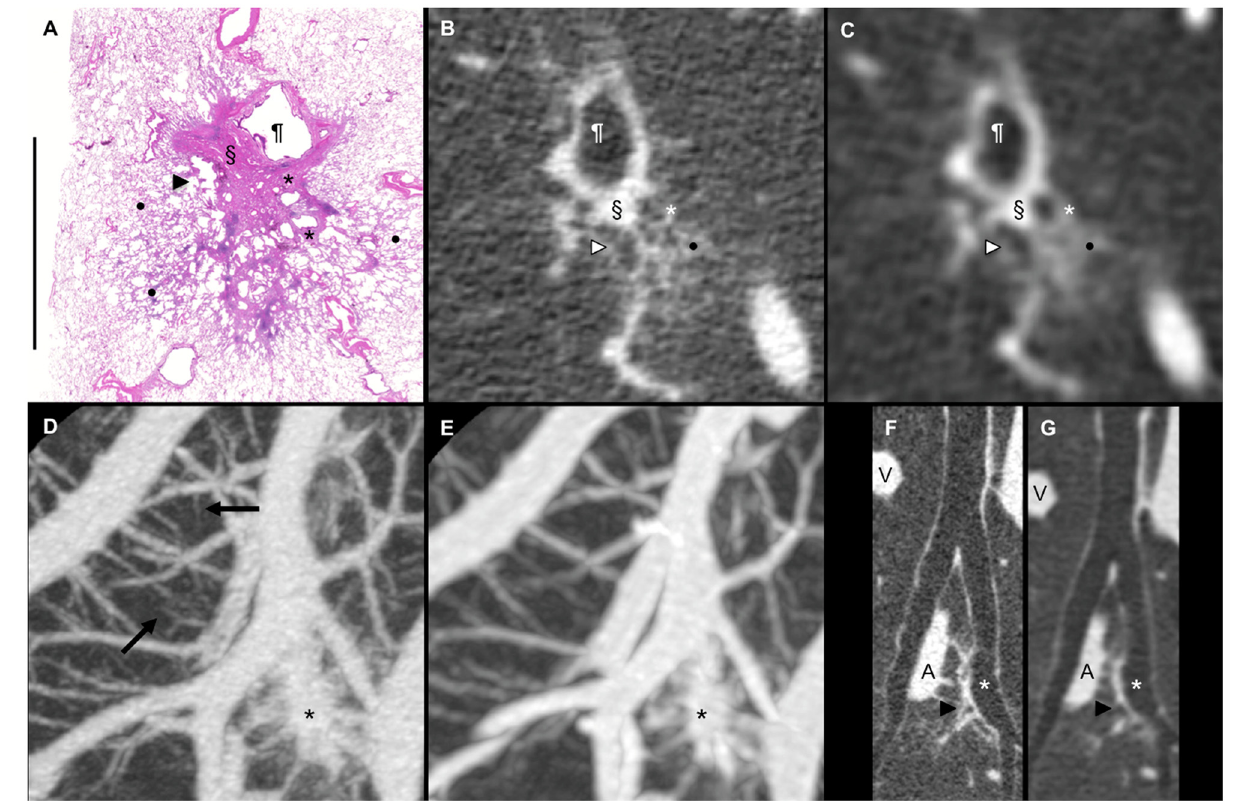
Fig 5. CT-pathologic correlation of an adenocarcinoma in situ. The patient was a 58-year-old female with adenocarcinoma in situ (size, 18 x 16 mm; pT1aN0M0, stage IA). The part-solid nodule was located in segment 6 of the right lower lobe. (A) Loupe view of the pathology specimen (Scale: 1 cm) (H & E, original magnification x1.25). (B) Multiplanar reconstruction (MPR) image from the ultra-high-resolution CT (U-HRCT) data corresponding to the pathology specimen. (C) MPR image from the conventional high-resolution CT (C-HRCT) data corresponding to the pathology specimen. U-HRCT image (Fig B) clearly depicting the solid component (§) immediately adjacent to the bronchial wall (¶) and low-attenuation areas, indicated by a white arrowhead and a white star, in the GGO component of the part-solid nodule. Collapse of the alveolar spaces (§) in Fig 5A corresponds to the solid component (§) of the part-solid nodule on the U-HRCT and C-HRCT images (Fig 5B and 5C), and the enlarged bronchiole (black arrowhead) and enlarged alveolar air spaces (black stars) in Fig 5A correspond to the low-attenuation areas (white arrowhead and white star) in the GGO component of the part-solid nodule on the U-HRCT and C-HRCT images (Fig 5B and 5C). The lepidic component indicated by the black dots in Fig 5A corresponds to the GGO component (black dot) of the part-solid nodule on the U-HRCT and C-HRCT images (Fig 5B and 5C). (D) Maximum intensity projection (MIP) image (2 cm thick) of the pulmonary vessels obtained from the U-HRCT data. (E) MIP image (4 cm thick) of the pulmonary vessels obtained from the C-HRCT data. Fine pulmonary vessels are depicted on the MIP image reconstructed from the U-HRCT data (black arrows). The size of the fine pulmonary vessels, as indicated by the black arrows (Fig 5D), was 0.2 mm. The black star in each MIP image indicates the part-solid nodule of the adenocarcinoma in situ. (F) 3D curved-MPR image of the pulmonary bronchi from the U-HRCT data. (G) 3D curved-MPR image of the pulmonary bronchi from the C-HRCT data. U-HRCT image (Fig 5F) clearly depicting the part-solid opacity (black arrowhead) immediately adjacent to the bronchial wall (white star) with traction bronchiectasis caused by the collapse of the alveoli in the tumor. A: pulmonary artery. V: pulmonary